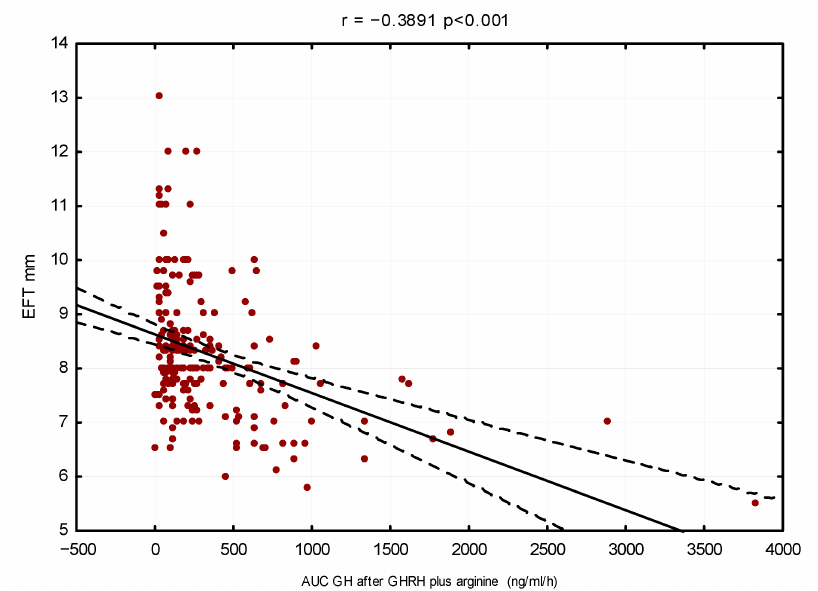
Figure 2. Linear regression between EFT (mm) and GH secretory capacity (AUC. ng/mL/hour)–adjusted for age, sex and BMI.